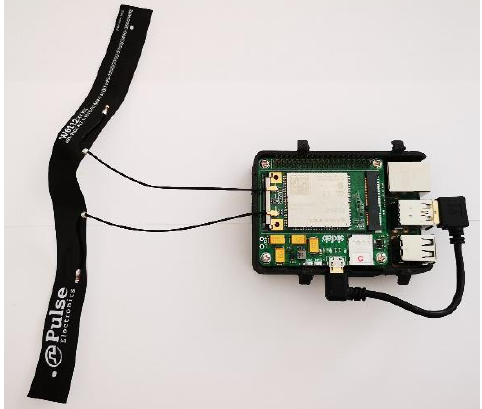
Figure 4. The Raspberry Pi SBC with the MiniPCI 4G/LTE Module used onboard the UAV to upload acquired images to the remote server.